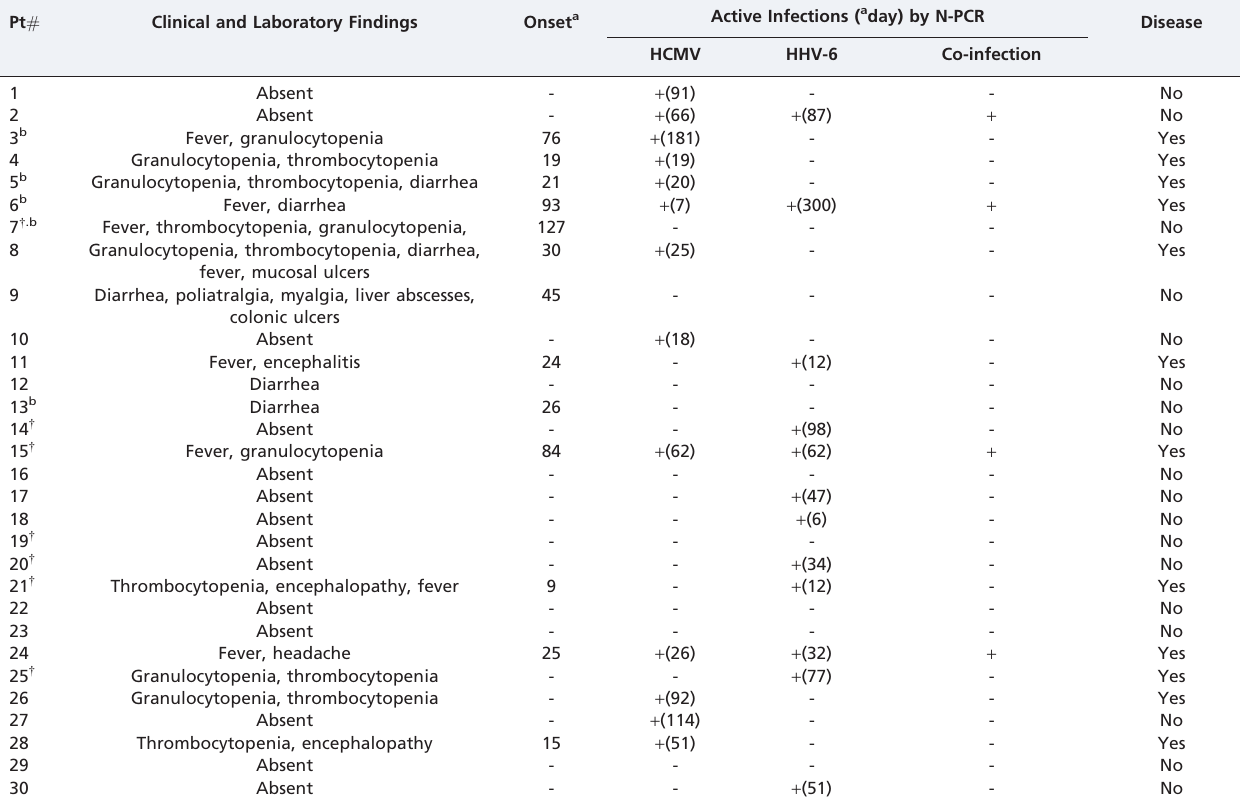
Table 1 - Clinical and laboratory findings, day of onset and N-PCR for HCMV or HHV-6 in liver transplantation patients. Pt